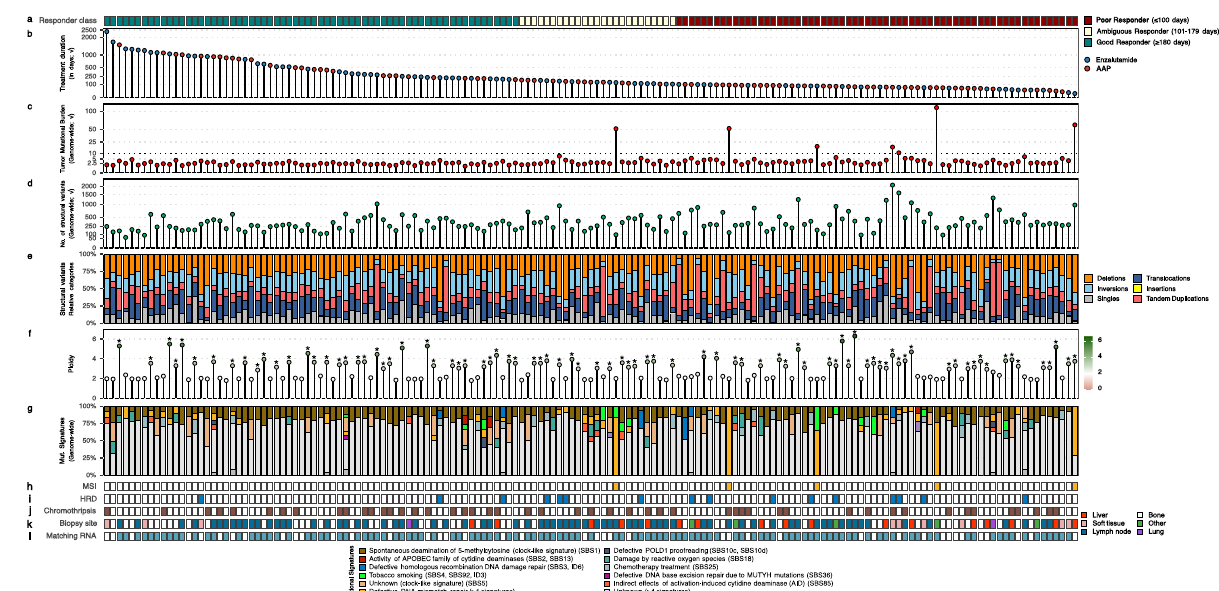
Fig.3|Genomiclandscapeofthediscoverycohort,orderedbyARSItreatment- durationandresponsecategory. Overviewofgenome-widecharacteristicsofthe discovery cohort (CPCT-02; DR-071; n =155) ordered by descending treatment duration (abiraterone acetate+prednisone or enzalutamide). For each mCRPC patient, the following tracks are shown: a Responder category. The responder categoryofeachsample,basedontreatmentduration(indays)onARSI. b Typeand duration of ARSI treatment. Y-axis representing the ARSI treatment duration (in days), whilst the coloring represents the type of given treatment (abiraterone acetate+prednisone in blue, enzalutamide in orange). Y-axis is shown in square- root transformed scale. c Tumor mutational burden (TMB). The number of geno- mic mutations averaged per megabase over the entire genome (TMB). Threshold for high-TMB status (TMB ≥ 10) is shown by a horizontal red dotted line. Y-axis is showninsquare-roottransformedscale. d Totalno.ofstructuralvariants.Thetotal number of structural variants (green) over the entire genome. This includes dele- tions, tandem duplications, translocations, inversions, insertions, and single-end breakpoints as detected by GRIDSS. Y-axis is shown in square-root transformed